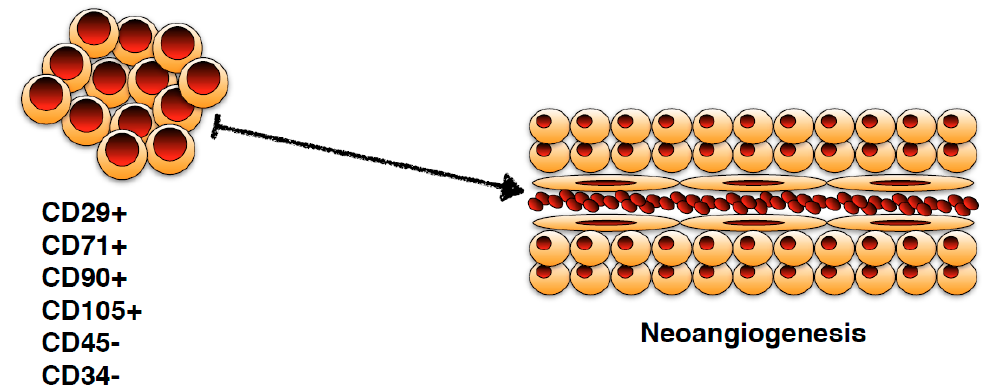
Figure 1. A schematic representation of bone marrow stem cells function. Starting from different immunophenotypes, these cellular populations are able to form new vascular tissue, consisting of endothelial cells and extravascular structures.